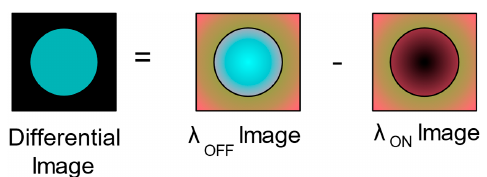
Figure 2. Generation of differential absorption